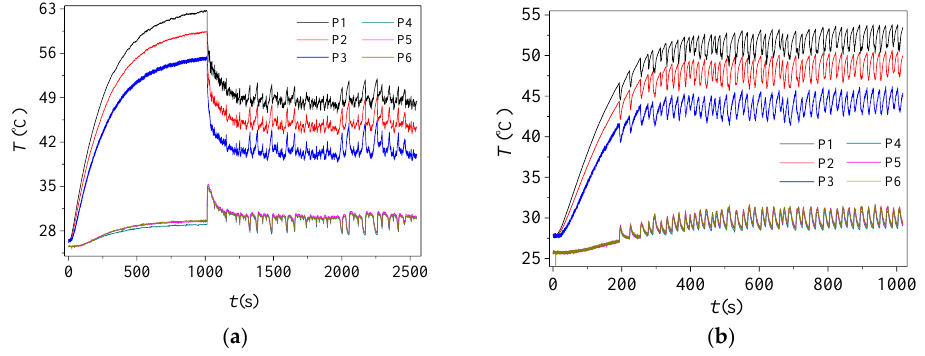
Figure 6. Dynamic wall temperature variations: ( a ) sudden startup mode ( φ = 73 %, q = 8.9 W/cm 2 ) and ( b ) gradual startup mode ( φ = 47 %, q = 8.5 W/cm 2 ).